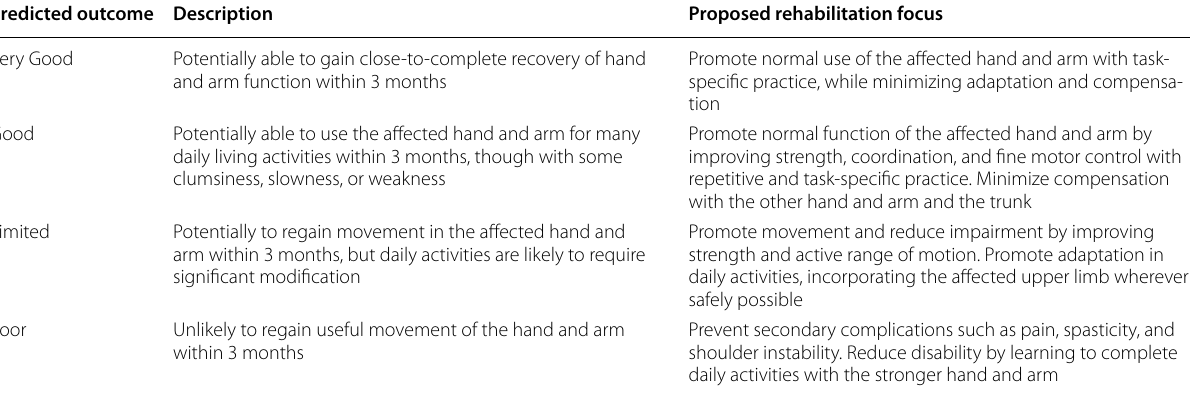
Table 4 Algorithm predictions Predicted outcome Description Proposed rehabilitation